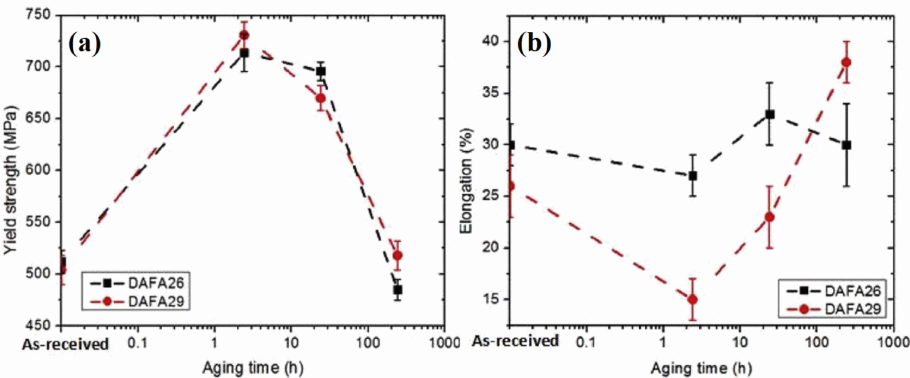
Figure 13. ( a ) Yield strength and ( b ) elongation of DAFA26 and DAFA29 as a function of aging time at 800 ◦ C